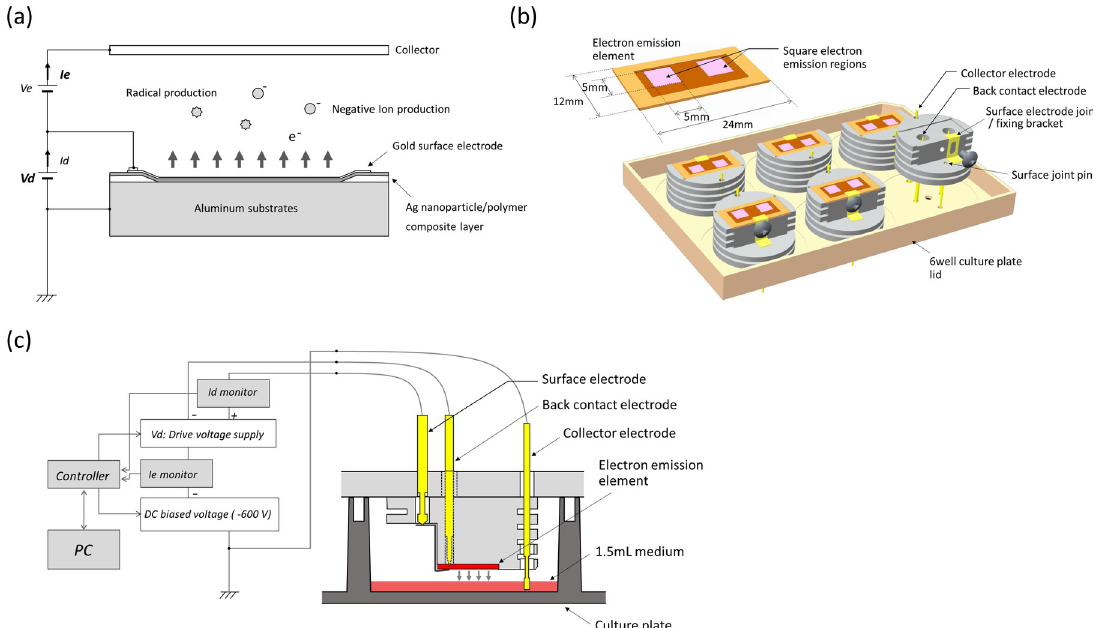
Fig 1. Our novel electron emission-based cell culture device and the EES system. (a) Schematic diagram of the electron emission element. The electron emission element emits electrons in the atmosphere when approximately 10–20 V (Vd: drive voltage) is applied. Emitted electrons fly to the collector along the electric field. The potential of the collector (Ve) is about 600 V higher than that of the element. The current in the element and the collector is expressed as Id and Ie, respectively. (b) 3D image of our novel electron emission- based cell culture device. The placement of six electron emission elements on an inverted modified 6-well culture plate lid is shown. An exploded view of the electron emission element highlights its components and their assembly, as well as the holes in the plate lid through which electrodes are inserted. (c) A principal schematic of the electron emission stimulation (EES) system. EES was given directly to cells in 1.5 ml of medium in the 6-well plate for 1 min. The stimulation condition can be modulated by a PC terminal through a controller.